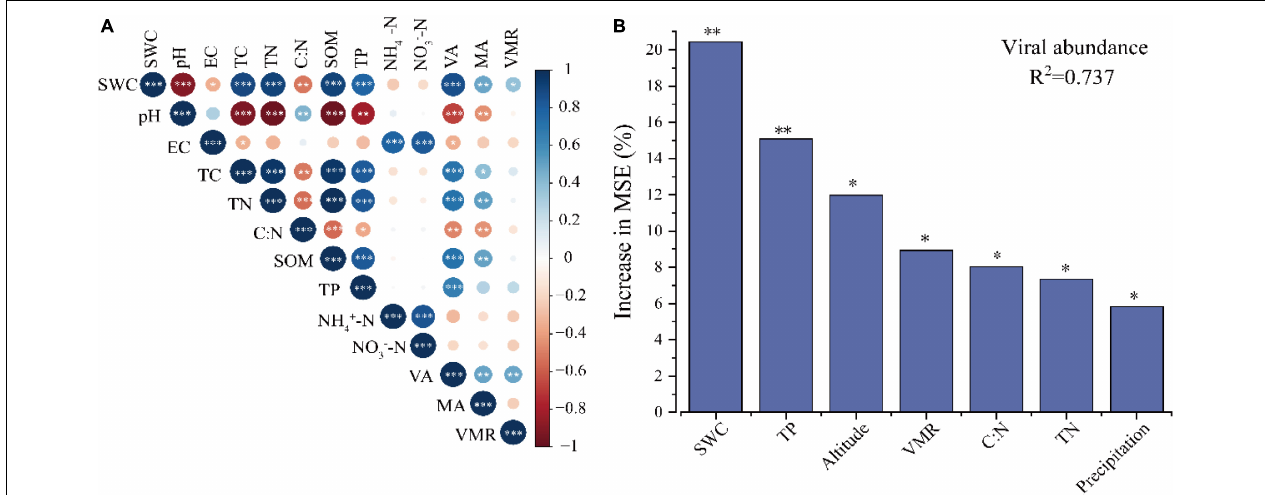
FIGURE 2 | Environmental factors influencing virus-like particles (VLPs) abundance. Correlation among VLPs abundance, microbial abundance, VMR and soil physical chemical properties (A) . Random forest model evaluating the relative importance of various factors influencing VLP abundance (B) . Only the factors with significant influence are shown in the figure (top 7), ∗ p < 0.05, ∗∗ p < 0.01.